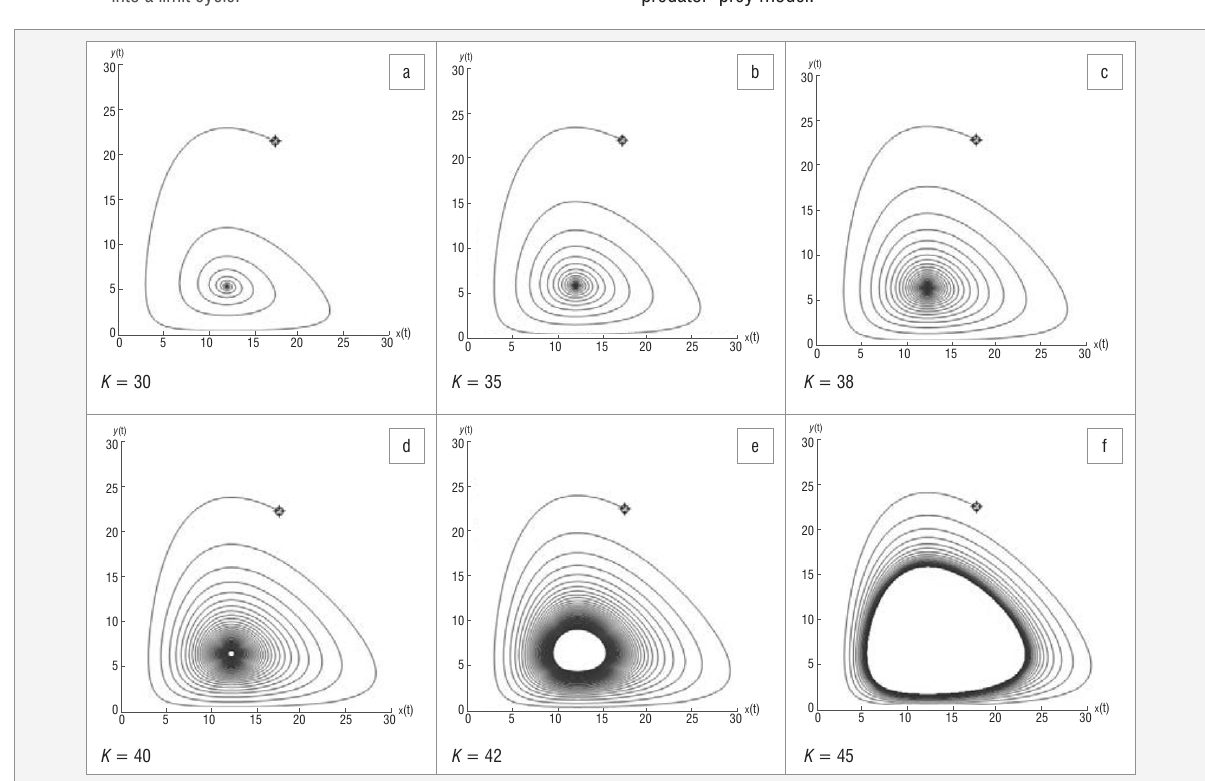
Figure 9: A Hopf bifurcation occurs as the value of K is increased from K < 42 through to K >